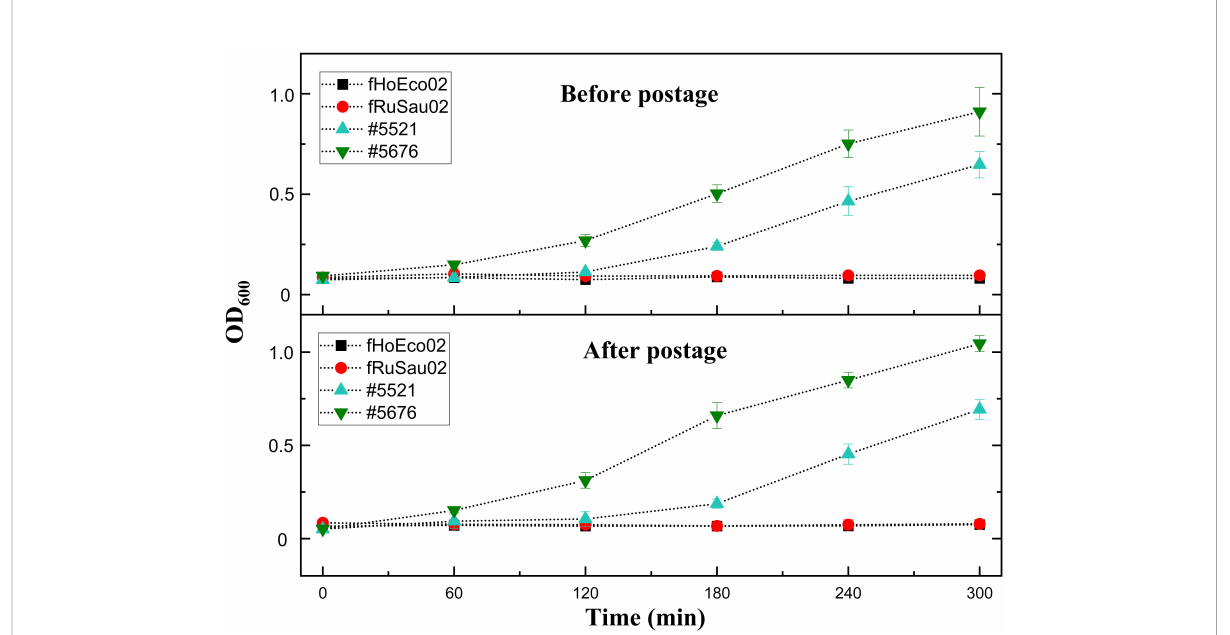
FIGURE 8 Phage transportation in ready-to-screen plates. Phages fHoEco02 and fRuSau02 were mixed with hydrogel and 10 droplets were added to the bottom of the microtiter well plates. Plates were then sealed and one of the plates was tested immediately after preparation. The other one was sent via post back to ourselves and tested after one week after its preparation. Phage viability was tested with the corresponding host strains #5521 (fHoEco02) and #5676 (fRuSau02). The measurement was done utilizing optimized liquid assay and absorbance